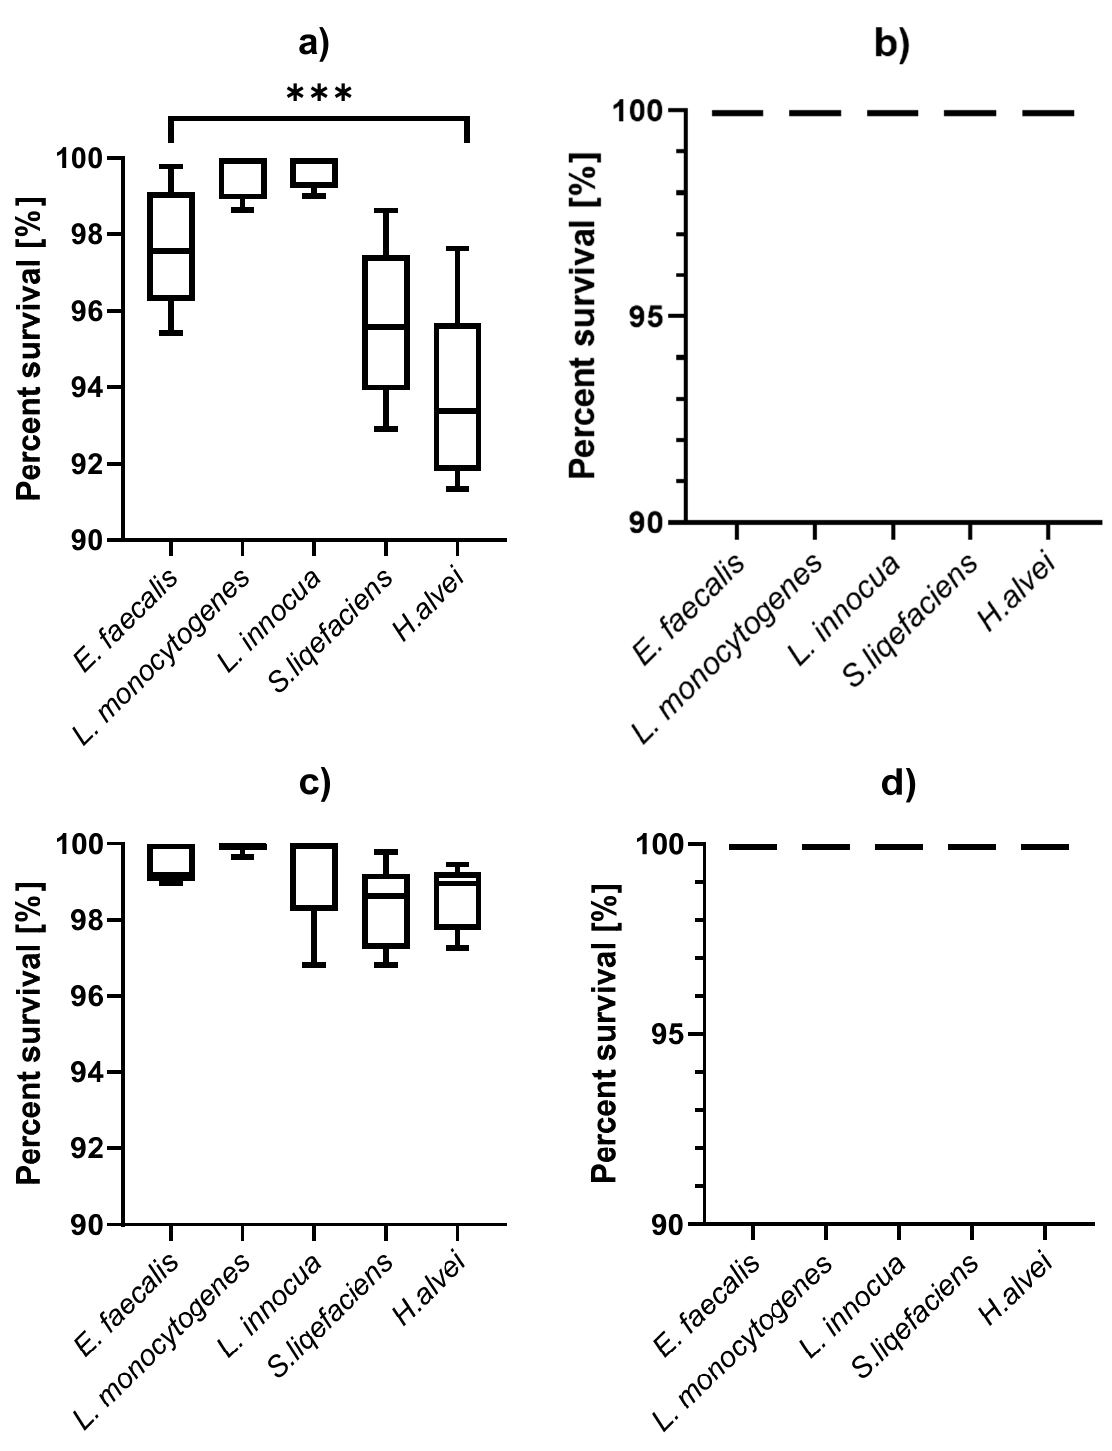
Figure 2. Reduction in the number of live cells of selected species by individual ceviche components: ( a ) lime (23.5%), ( b ) habanero (0.6%), ( c ) onion (5%), ( d ) coriander (3%), ***— p < 0.0001.